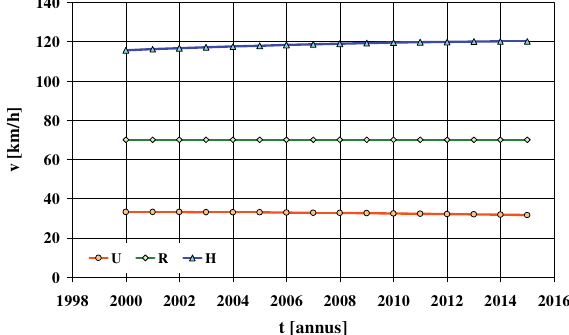
Fig. 4. Average velocity of passenger cars in towns, outside towns, on highways and expressways